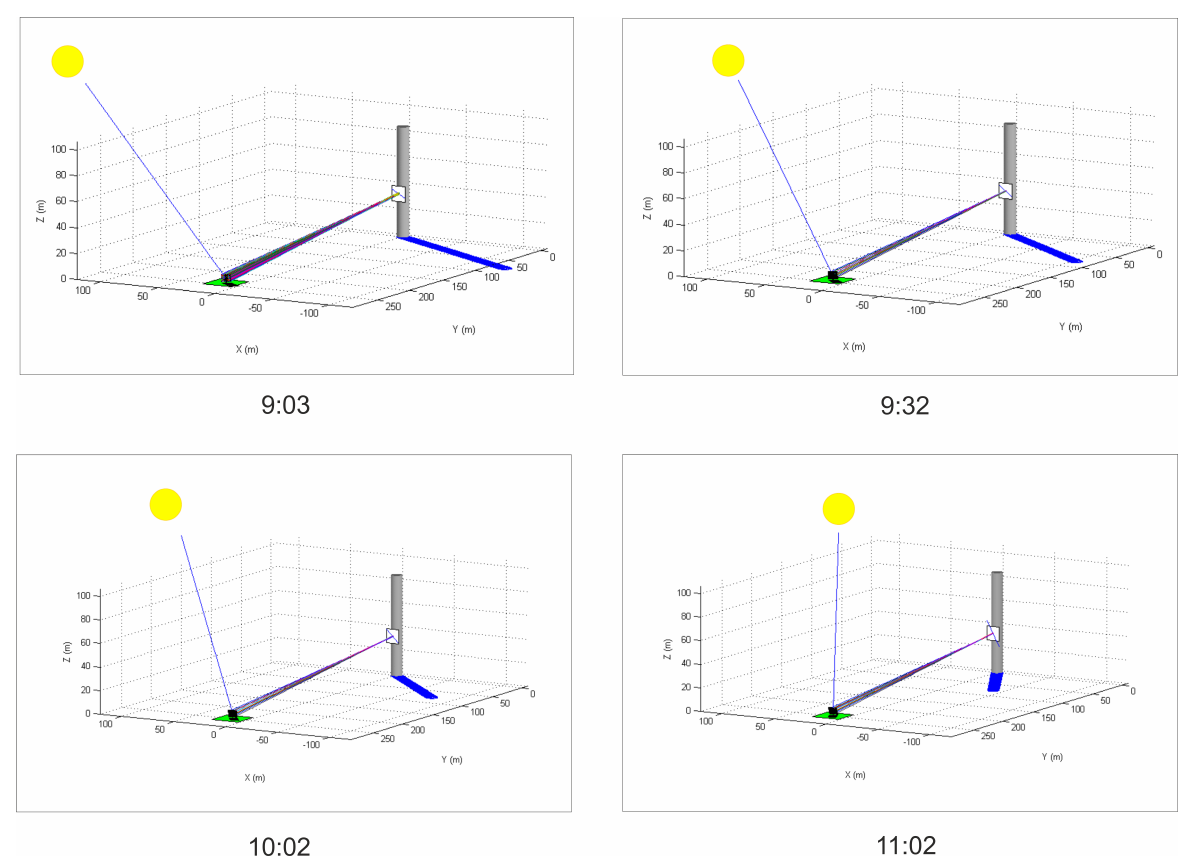
Figure 5. Scheme of the DNI forecasting simulation on the target (9 March 2017 at 12:02